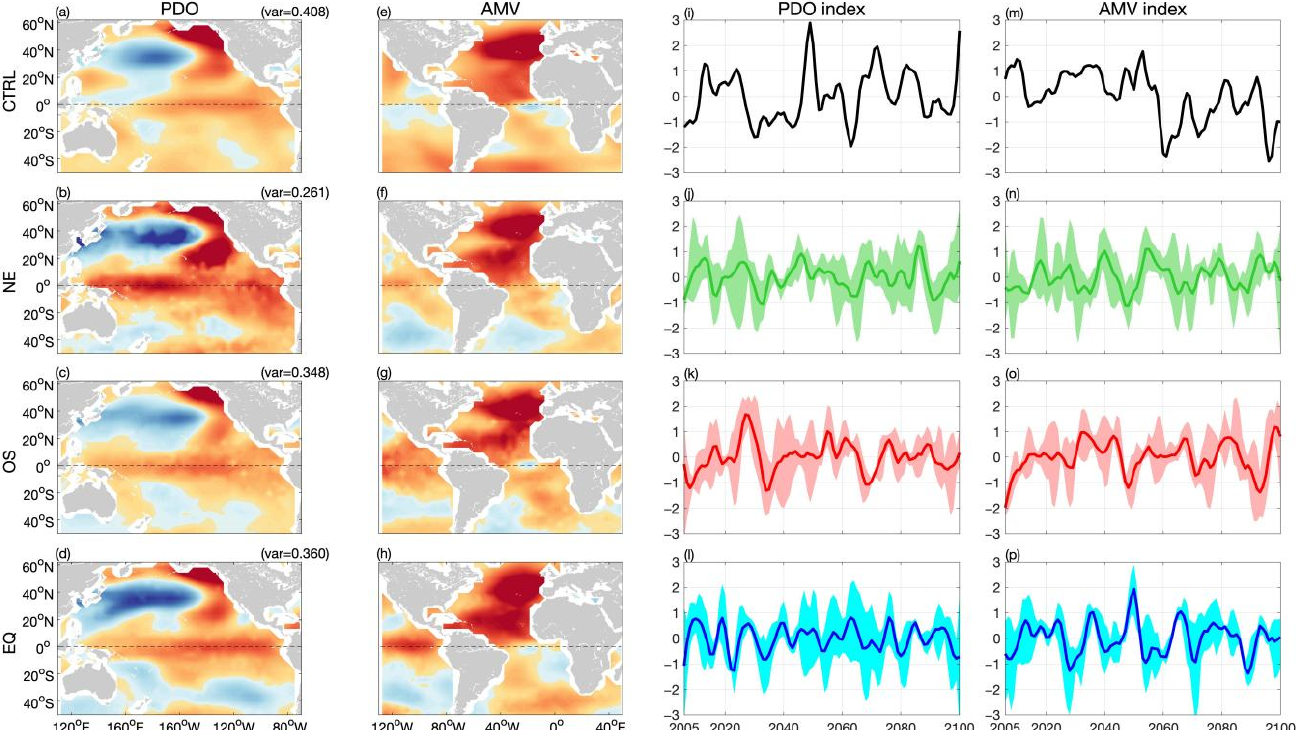
Figure 6. PDO and AMV spatial regression pattern ( a – h ) from simulations of CTRL, NE, OS, and EQ, respectively. The explained variance for the first EOF mode of North Pacific annual mean SSTA is given at the upper right of each panel ( a – d ). PDO and AMV index ( i – p ) for four simulations. The shaded regions in ( j – l , n – p ) are calculated from three members of each experiment.